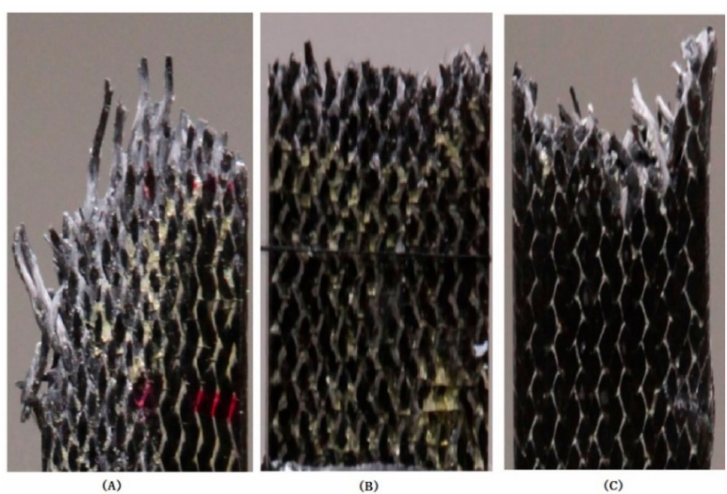
Figure 5. Fracture surface shapes of specimens ( A ) B-V1, ( B ) B-V2, and ( C )